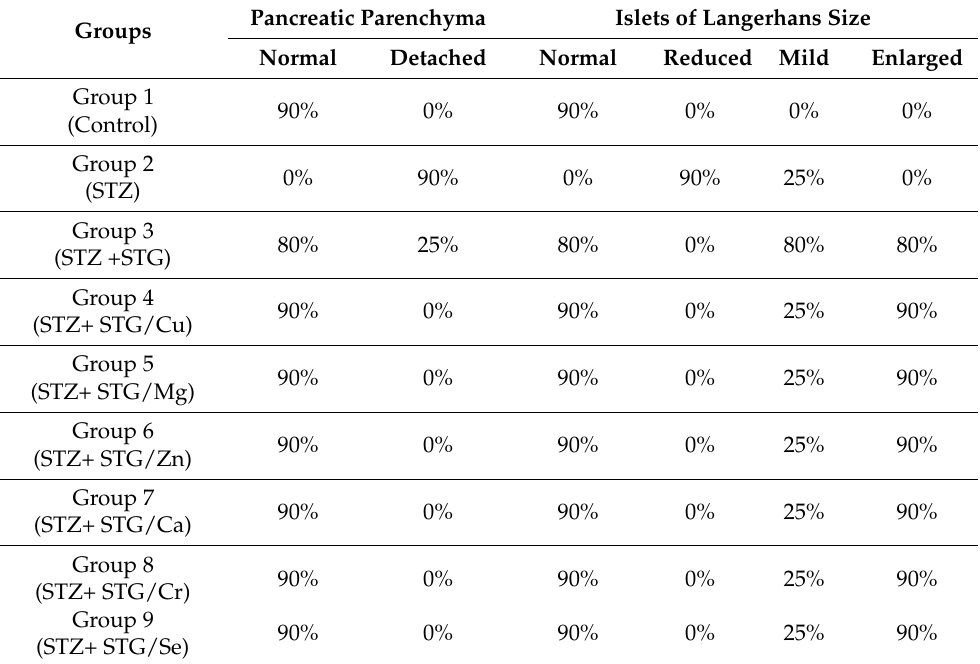
Table 6. Histopathological findings in the pancreatic tissues of normal rats, untreated diabetic rats, and diabetic rats treated with either STG, Cu/STG, Mg/STG, or Zn/STG. Pancreatic Parenchyma Islets of Langerhans Size Groups Normal Detached Normal Reduced Mild Enlarged Group 1 90% 0% 90% 0% 0% (Control)